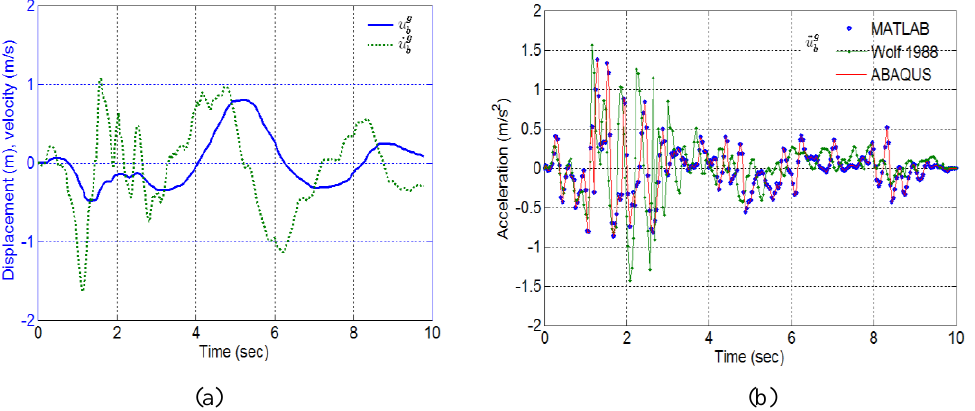
Figure 3. (a) Input ground motion, (b) Acceleration response of the mass attached to spherical cavity